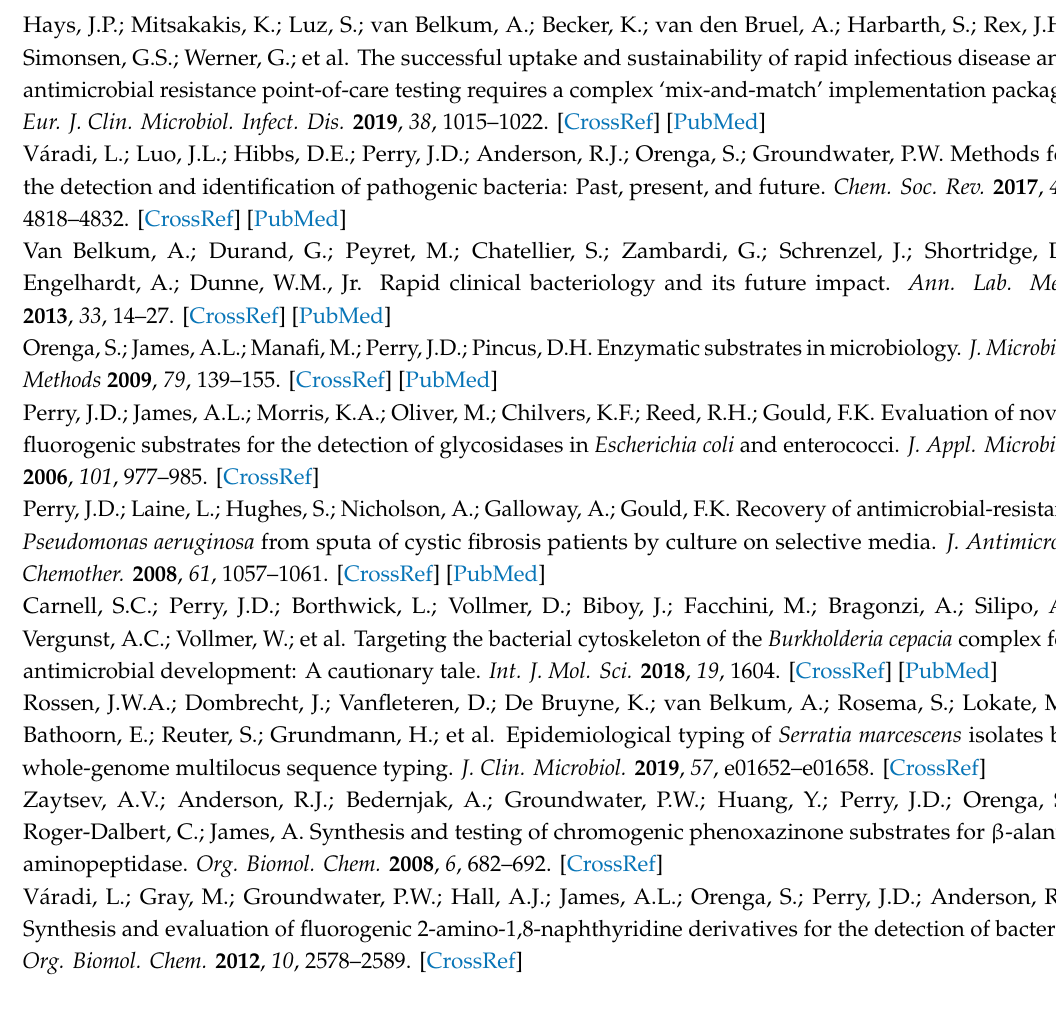
(a) intensity, (b) RGB, (c) red, (d) green, (e) blue values for spot #20 as an example for typical growth-inhibited species; Figure S2: Histograms of (a) intensity, (b) RGB, (c) red, (d) green, (e) blue values for spot #16 as an example for semi-inhibited BAP-negative species; Figure S3: Histograms of (a) intensity, (b) RGB, (c) red, (d) green, (e) blue values for spot #3 as an example for well-grown BAP-negative species; Figure S4: Histograms of (a) intensity, (b) RGB, (c) red, (d) green, (e) blue values for spot #7 P. aeruginosa BAP-positive strain; Figure S5: Histograms of (a) intensity, (b) RGB, (c) red, (d) green, (e) blue values for spot #5 S. marcescens BAP-positive strain; Figure S6: Histograms of (a) intensity, (b) RGB, (c) red, (d) green, (e) blue values for spot #9 B. cepacia BAP-positive strain; Figure S7: Bar charts of ImageJ histogram values of the spot-inoculated colonies for each of the 20 strains of (a) green, and (b) blue component; Figure S8: Streaked colonies; intensity, and respective R, G, B values and their ratios based on ImageJ image processing of the plates under a 365 nm light source, and RGB histograms of (a) E. cloacae (BAP-negative), (b) P. aeruginosa (BAP-positive), (c) mixed culture of E. cloacae and P. aeruginosa ; Figure S9: 1 H-NMR of 10 in DMSO- d 6 ; Figure S10 HRMS of 10 ; Figure S11: 1 H-NMR of 7 in DMSO- d 6 ; Figure S12: HRMS of 7 ; Figure S13: 1 H-NMR of 12 in DMSO- d 6; Figure S14: HRMS of 12 ; Figure S15: 1 H NMR of 9 in DMSO- d 6; Figure S16: HRMS of 9